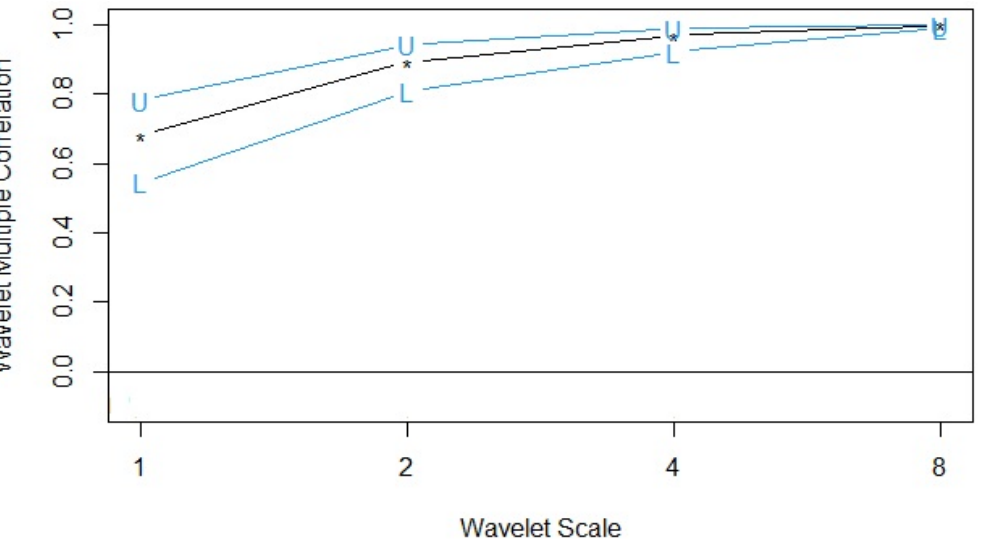
Figure 10. WMC among the indicators of GSE and interest rates. U—upper limits, L—lower (at 95% confidence interval), *—plots of actual WMC values. Table 4. WMC among the indicators of GSE and interest rates.